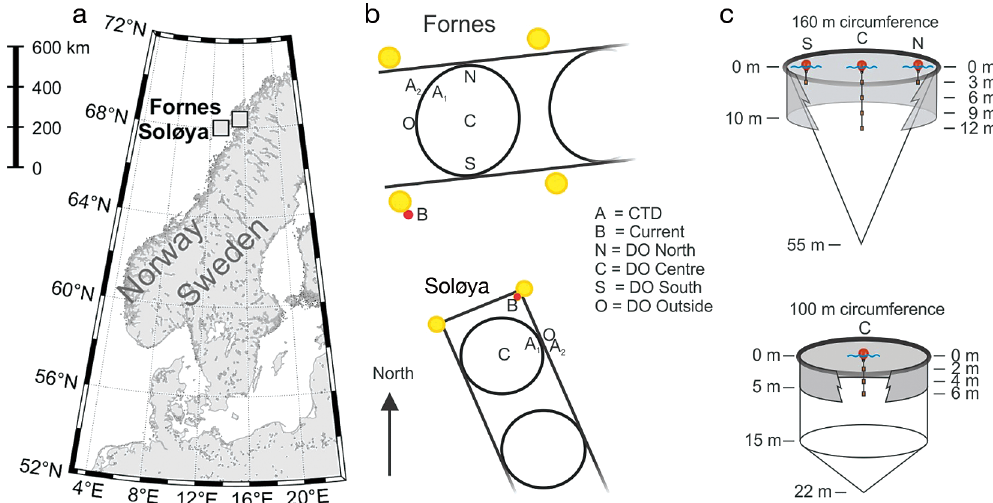
Fig. 1. (a) Locations of sites where measurement campaigns were carried out: Soløya in May 2019, and Fornes in July 2019. (b) Measurement positions of dissolved oxygen (DO), conductivity, temperature and depth (CTD) and current profiles at Fornes and Soløya. (c) Schematic diagram of the sea-cages. DO was measured at position O outside the cage at 3 m depth at Fornes and Soløya. DO was also measured in position C at 3, 6, 9 and 12 m at Fornes and at 2, 4 and 6 m at Soløya. At Fornes, DO was also measured at 3 m depth in positions N and S, 4 m from the floating collar. The CTD profiles were measured manually inside and outside the cage at positions A 1 and A 2 , respectively. Current speed and direction profiles were measured at position